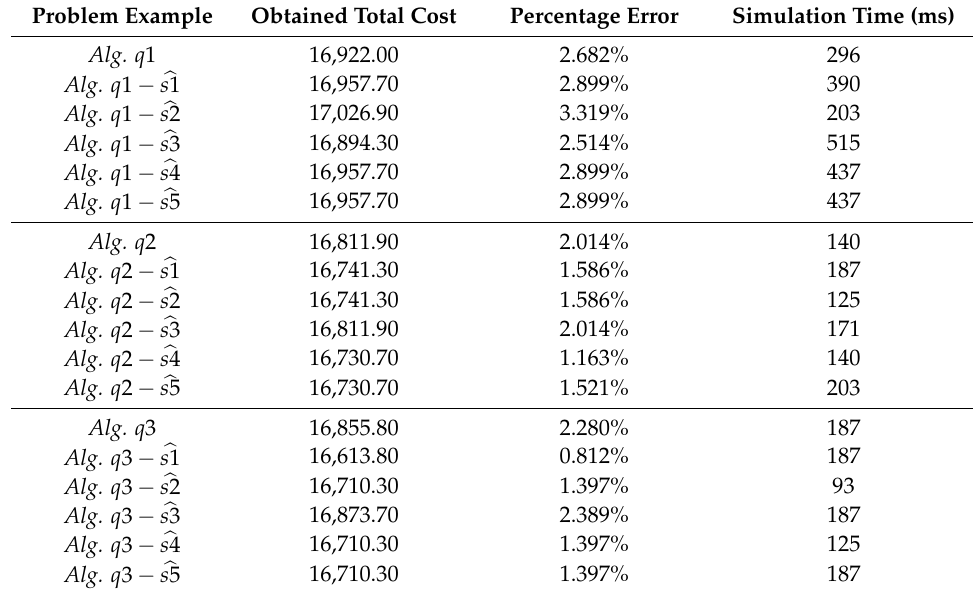
Table 4. Obtained results for regular network GR-1a (Suboptimal cost